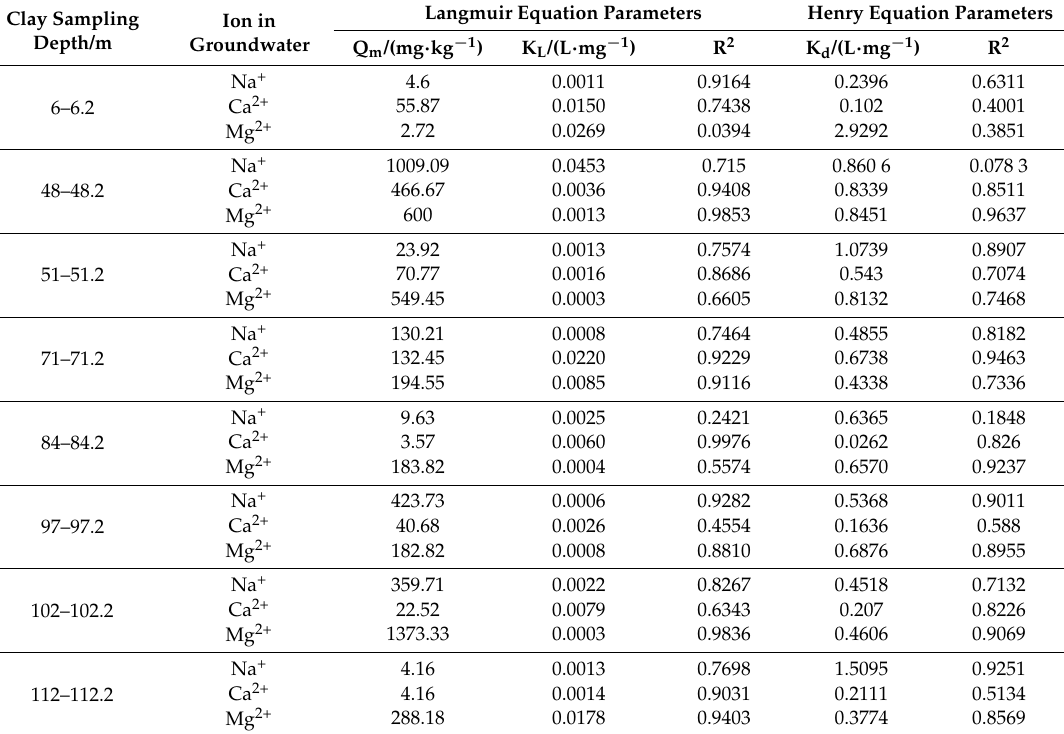
Table 4. The adsorption isotherm model fitting parameters of different clay depth adsorptions for Na + , Ca 2+ and Mg 2+ in the